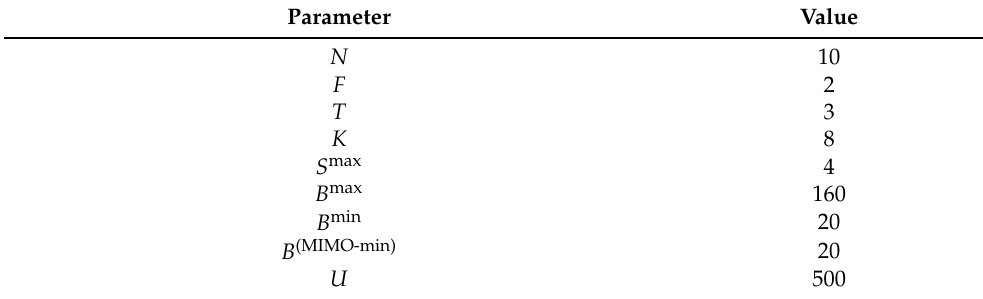
Table 2. Model Parameters.